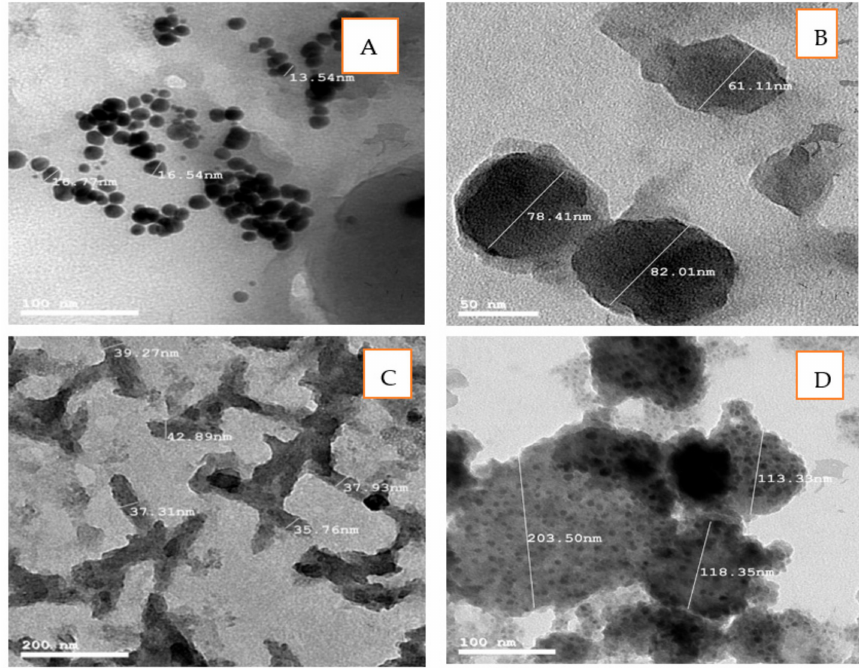
Figure 2. TEM image of ( A ) AuNPs biosynthesized by Chlorella vulgaris ; ( B ) Horizontal section nanocellulose fibril biosynthesized by Chlorella vulgaris ; ( C ) nanofibrils distributions; ( D ) Au/ cellulose